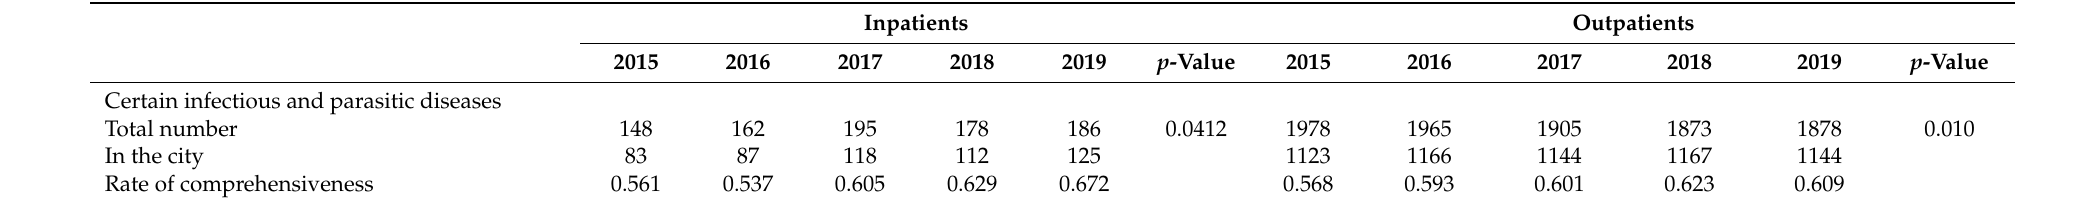
Table 2. ICD-10 categories and rates of